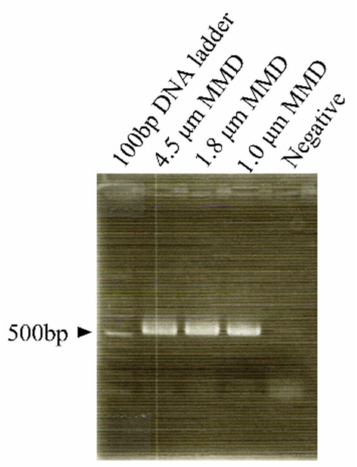
Figure 5. PCR results obtained universal primers for bacterial 16SrDNA amplification. Negative controls were subjected to the same procedures but without DNA extraction from MMD-captured aerosol particles.